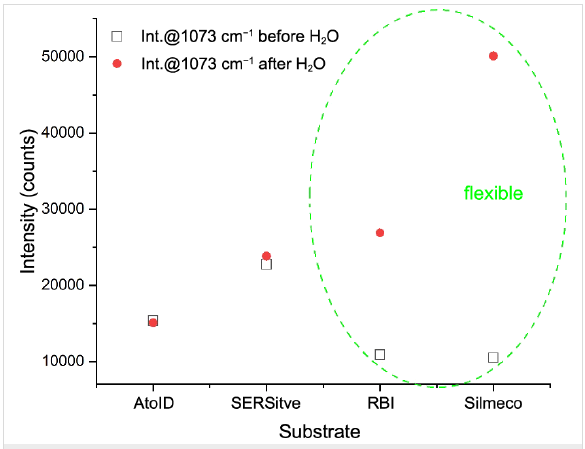
Figure 11: Intensity at 1073 cm − 1 for the samples fabricated in differ- ent